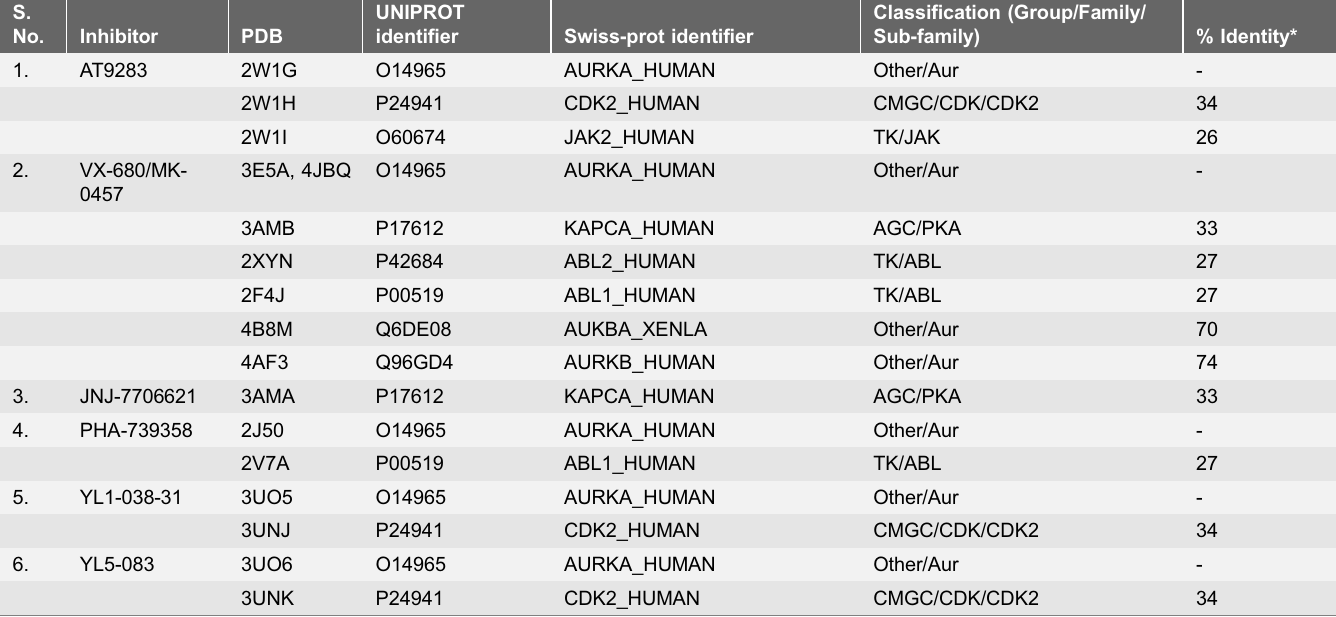
*A pairwise sequence alignment of AURKA_HUMAN against the individual kinases was done with blast-p to calculate the sequence identity.